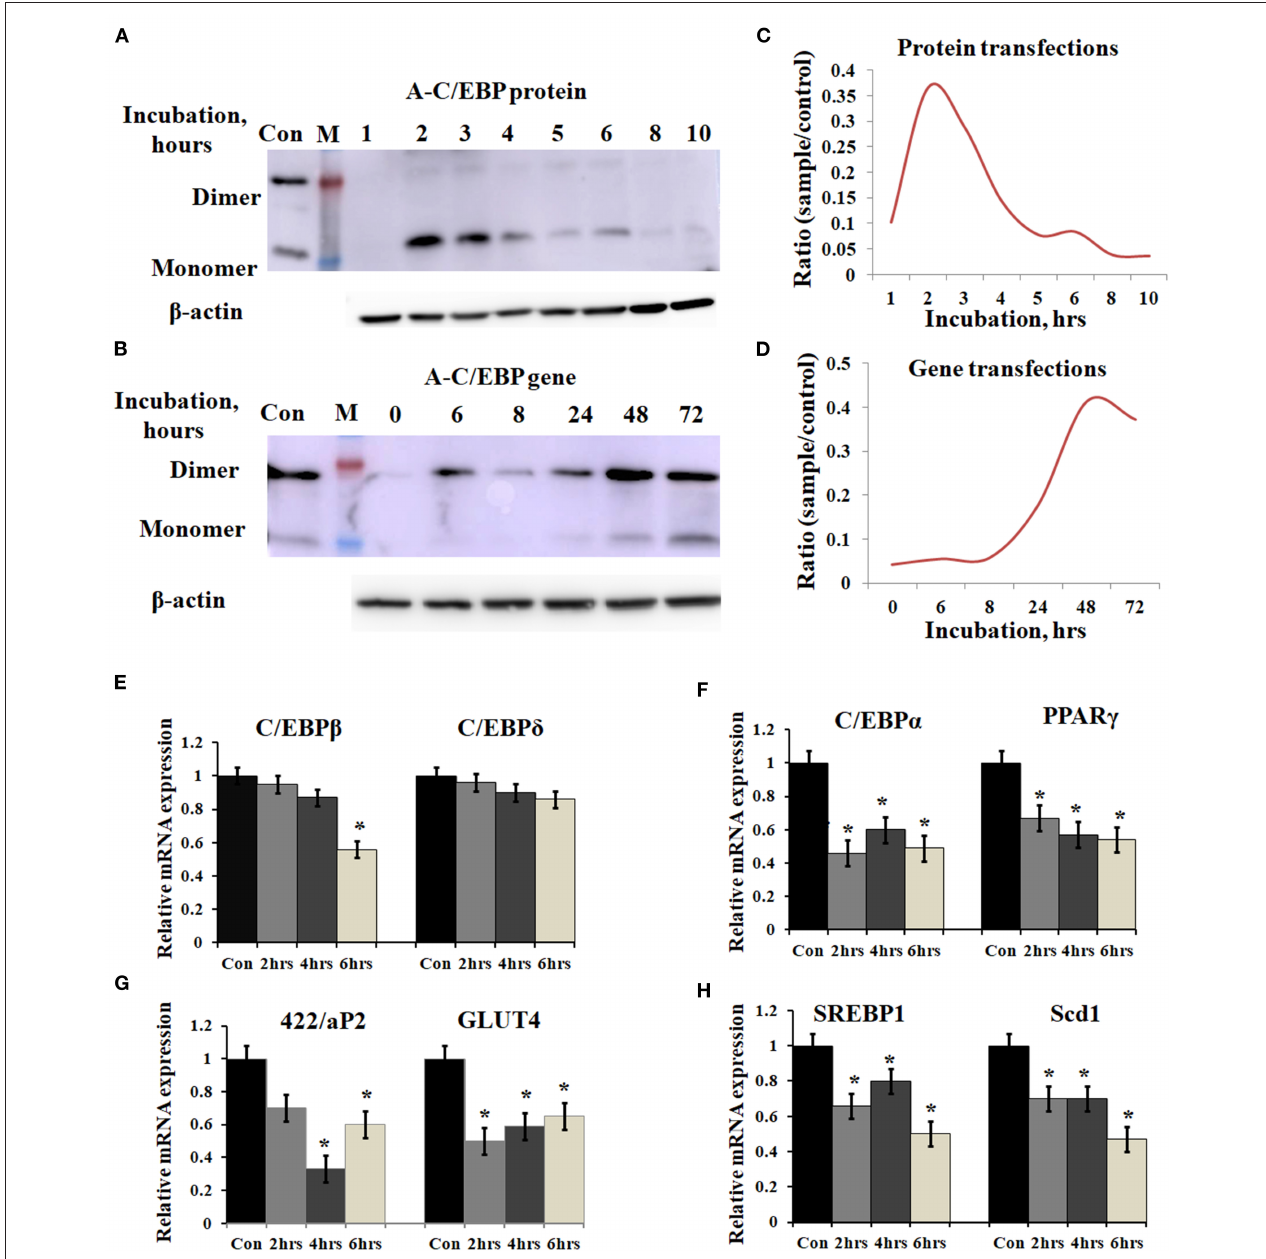
FIGURE 2 | Time-dependent presence of A-C/EBP protein and A-C/EBP gene products in 3T3-L1 cells and effect of A-C/EBP protein on adipocyte marker genes. (A) Western blots show the signals of A-C/EBP protein when the cells were treated with liposome-entrapped A-C/EBP protein. With time, signal intensity decreased due to degradation of A-C/EBP protein. Pure protein was used as control. (B) Western blot shows the time-dependent profile of A-C/EBP gene product. Here, the signal intensity increased and peaked at 48h and remained so at 72h. Pure protein was used as control. (C,D) Curves show A-C/EBP signal trends plotted from Western blot experiments over indicated time. Opposite trends were obtained in protein- and gene-transfected cells. *Significantly different from the control group ( p < 0.05). Values are expressed as mean ± SD; n = 3 independent experiments. (E–H) Real-time PCR analysis of C/EBPs and PPAR γ , 422/aP2 , GLUT4 , SREBP1 , and Scd1 w.r.t β -actin in cells transfected with A-C/EBP for 2, 4, and 6h before differentiation. *Significantly different from control ( p < 0.05). Values are expressed as mean ± SD; n = 6 independent experiments.